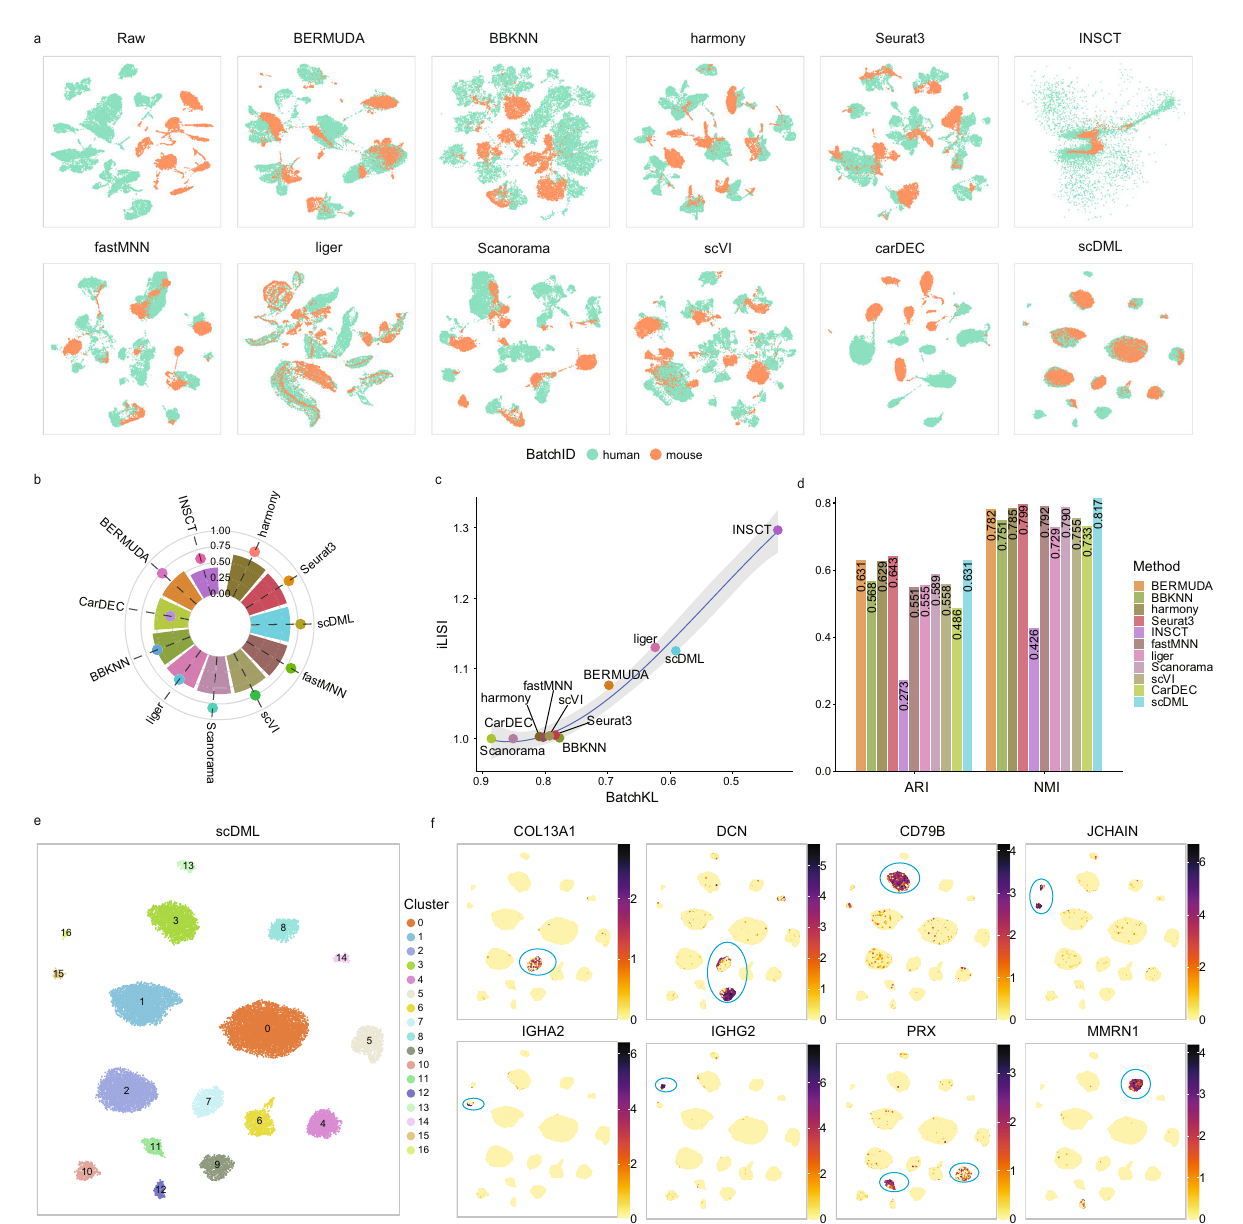
Fig. 3 | scDML accurately preserves rare cell types from original dataset and removes batch effect. a – f for the human pancreas dataset: ( a ) UMAP embedding computedfromcomparedmethods,inwhichthepointsarecoloredbybatch. b Bar plot shows the value of ASW_celltype and ASW_batch, in which the bar height denotes the value of ASW_celltype and the point height denotes the value of ASW_batch.HigherASW_celltypeandlowerASW_batchmeansbetterperformance. c Scatter plot shows the value of BatchKL (x-axis) and iLISI (y-axis). Point closer to the upper right means better performance. The error band means con fi dence intervalof0.95levelaroundsmoothusingB-splinesmoothingfunctionwithdegree equalto3. d BarplotshowsthevalueofARIandNMIfordifferentmethods.Higher